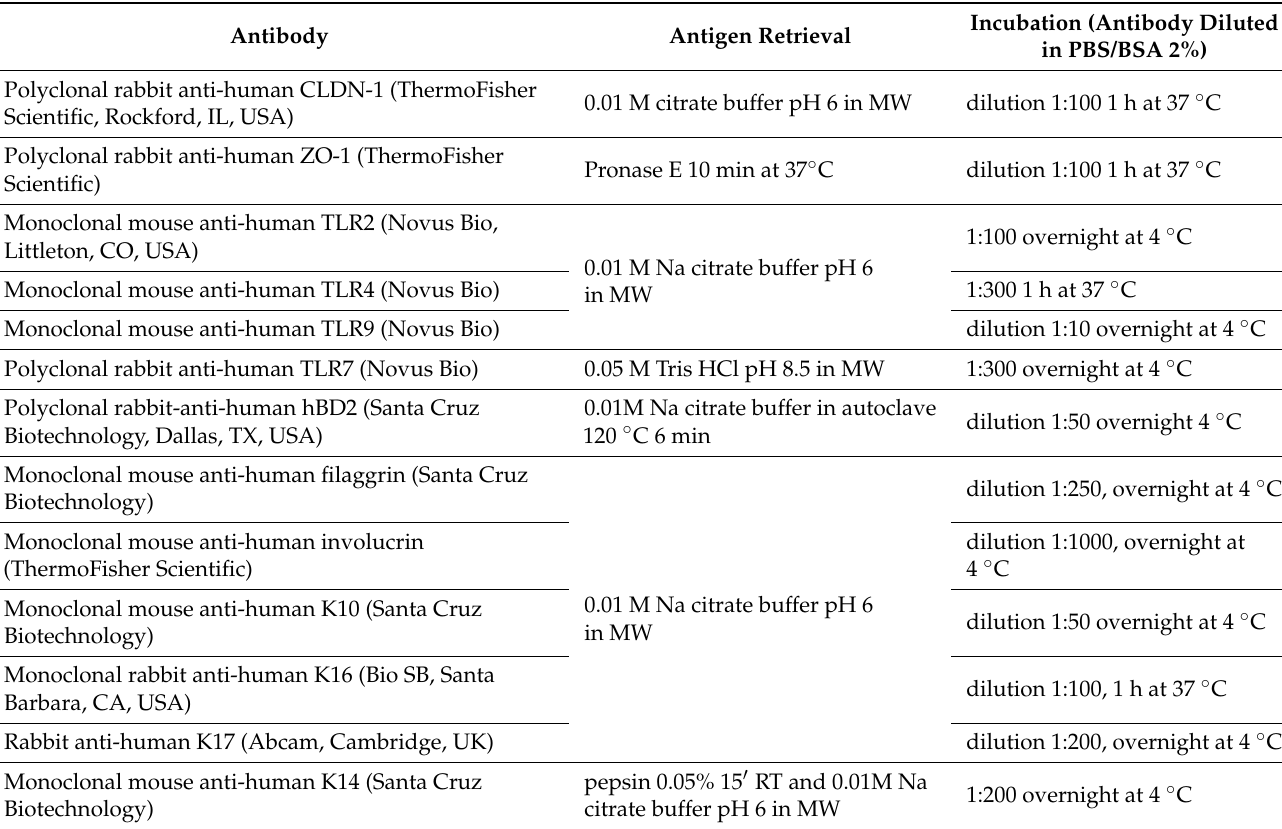
Table 1. Antibodies and protocols for indirect immunofluorescence